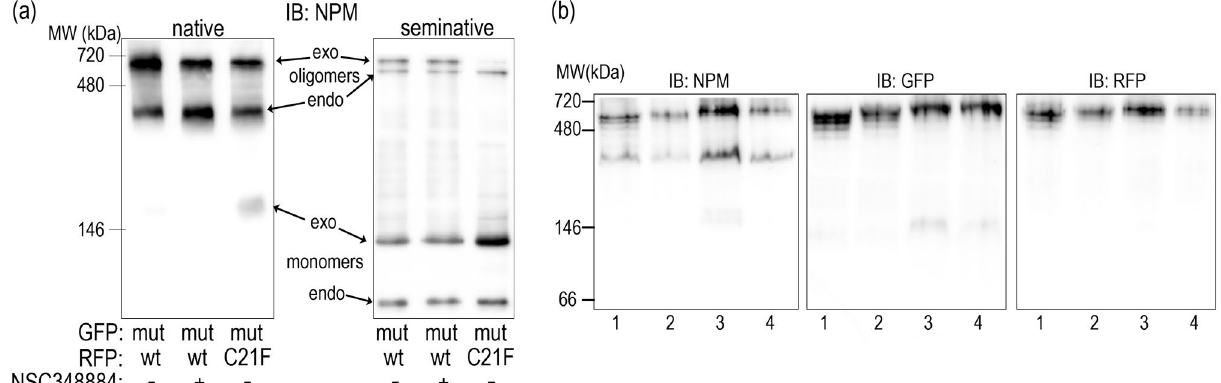
Figure 10. Native and semi-native PAGE from 293T cells transfected with various fluorescent variants of NPM and treated with 10 µM NSC348884 for 24 h. ( a ) Cells co-transfected with G_NPMmut and R_NPMwt (lanes 1 and 2) or R_C21F (lane 3). Endogenous NPM, R_NPMwt and G_NPMmut oligomers detected in untreated (lanes 1 and 3) and NSC348884-treated (lane 2) cells. ( b ) Native PAGE, G_NPMwt + R_NPMwt (1, 2) and G_